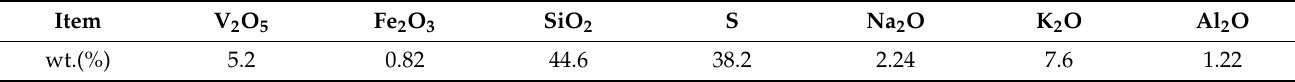
Table 4. Constituent analysis of the spent